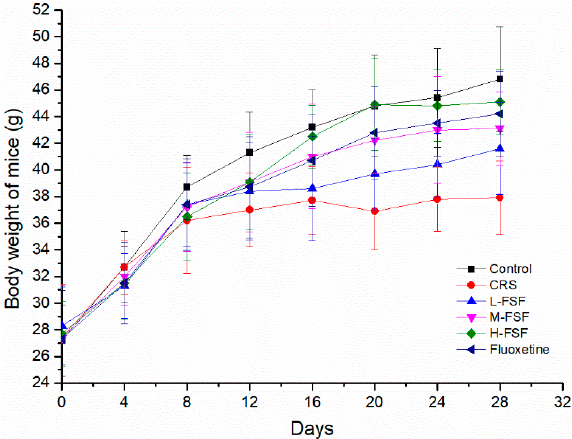
Figure 3. Body weight of mice during the period of chronic restraint stress, n = 10.